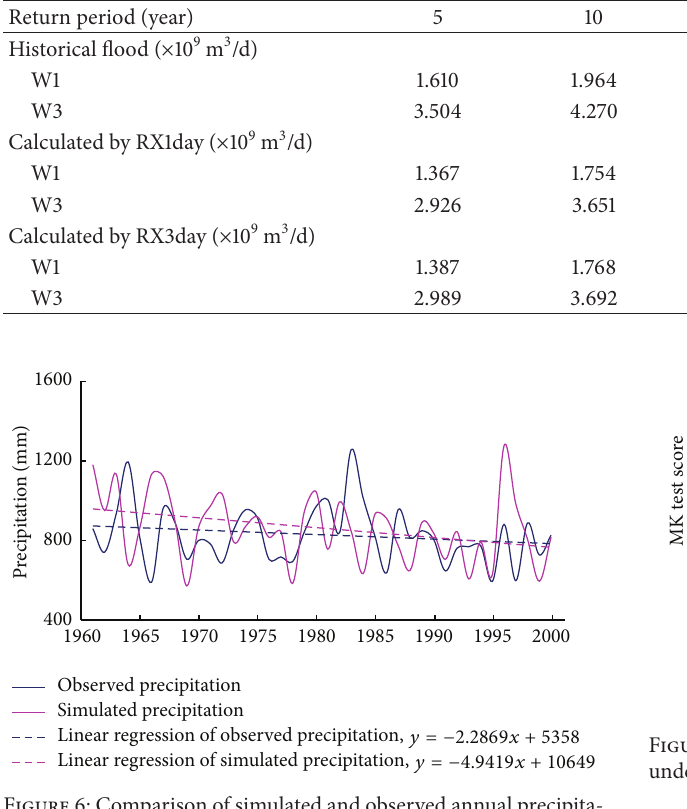
Figure 6: Comparison of simulated and observed annual precipita- tion in the study area.